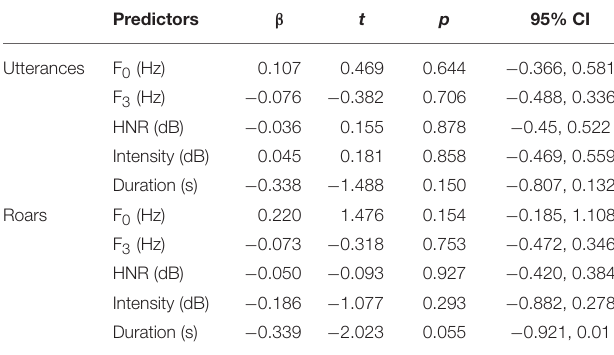
TABLE 5 | Summary of multiple linear regression analysis for acoustic predictors of fighting success based on utterances and roars.